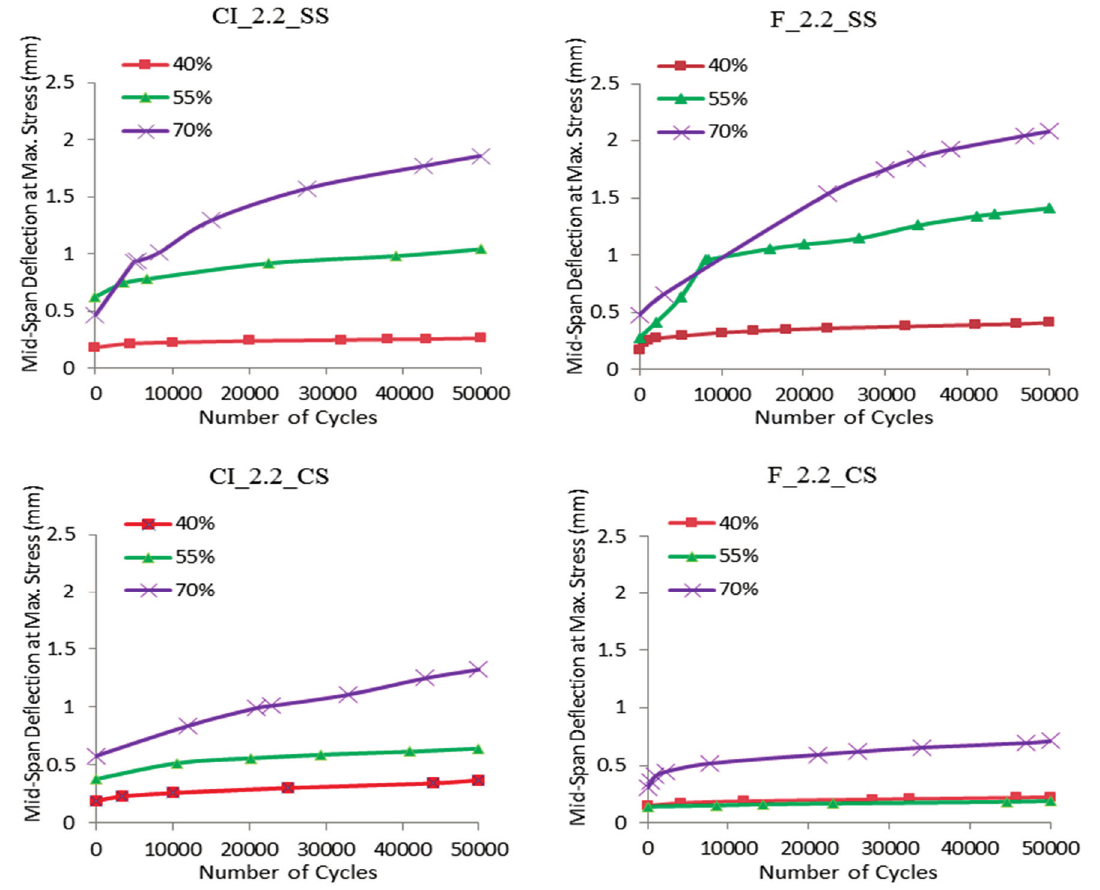
Figure 3. Evolution of mid-span deflection at different fatigue stress level (Phase